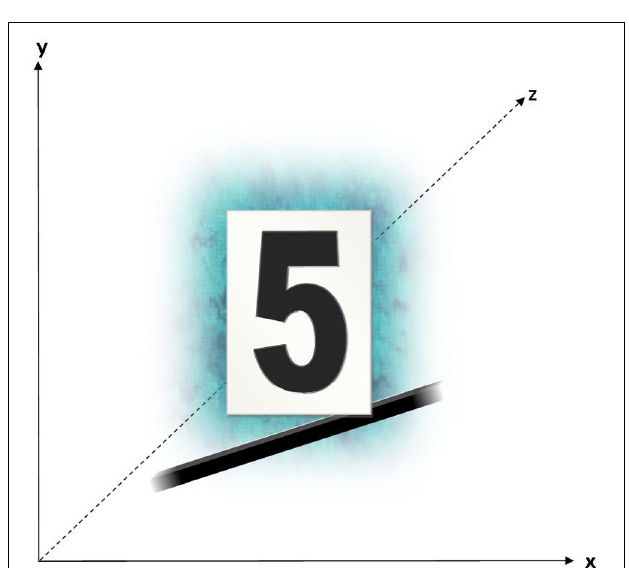
descriptions are provided at each level, and the collated transcript references supporting our interpretation are provided at the bottom-most level for each theme.